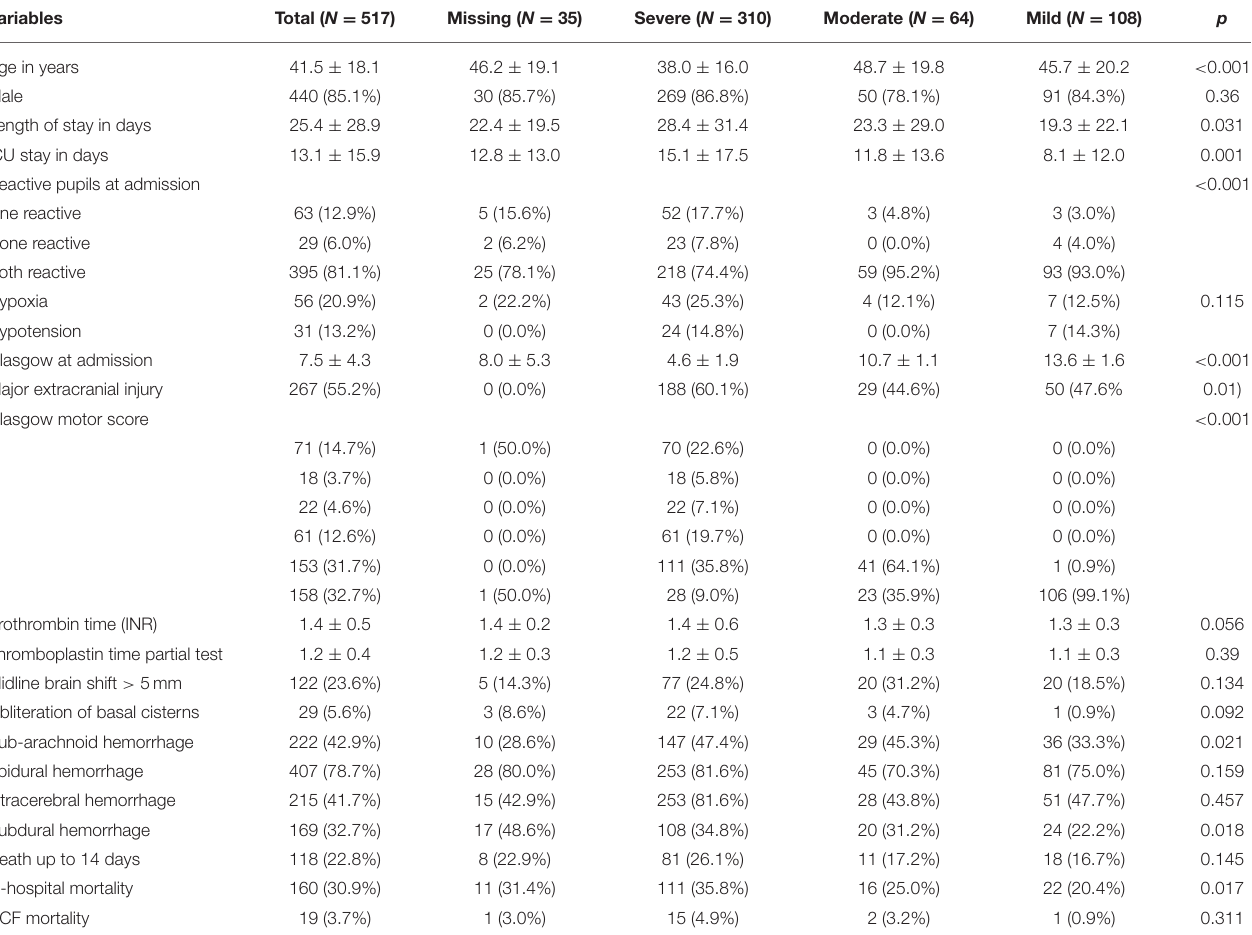
TABLE 1 | Sample description stratified by TBI